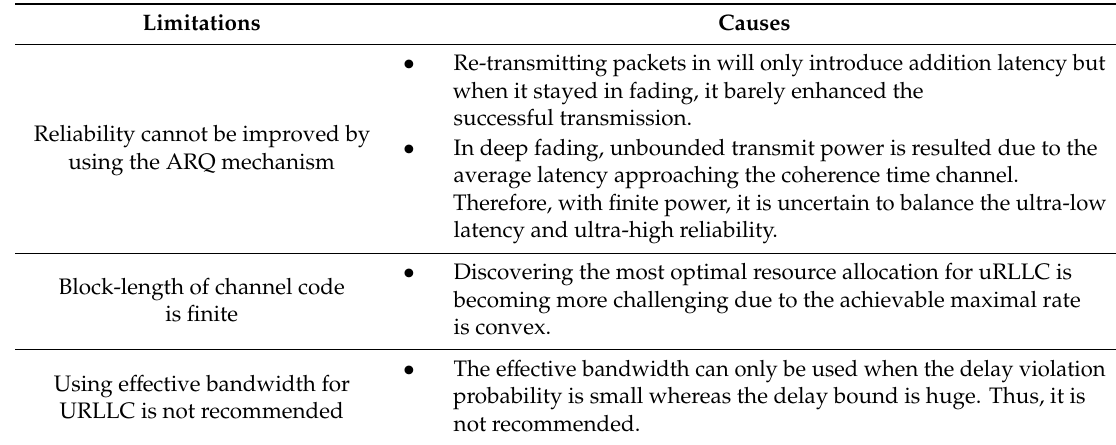
Table 7. Limitations and its causes in cross-layer for low-latency massive